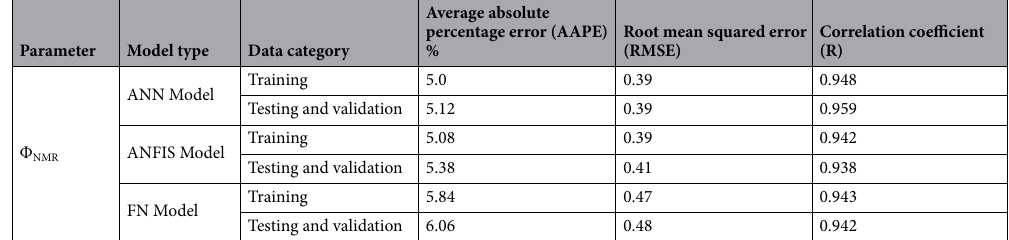
Table 5. Accuracy indicators for the ANN, FN and ANFIS